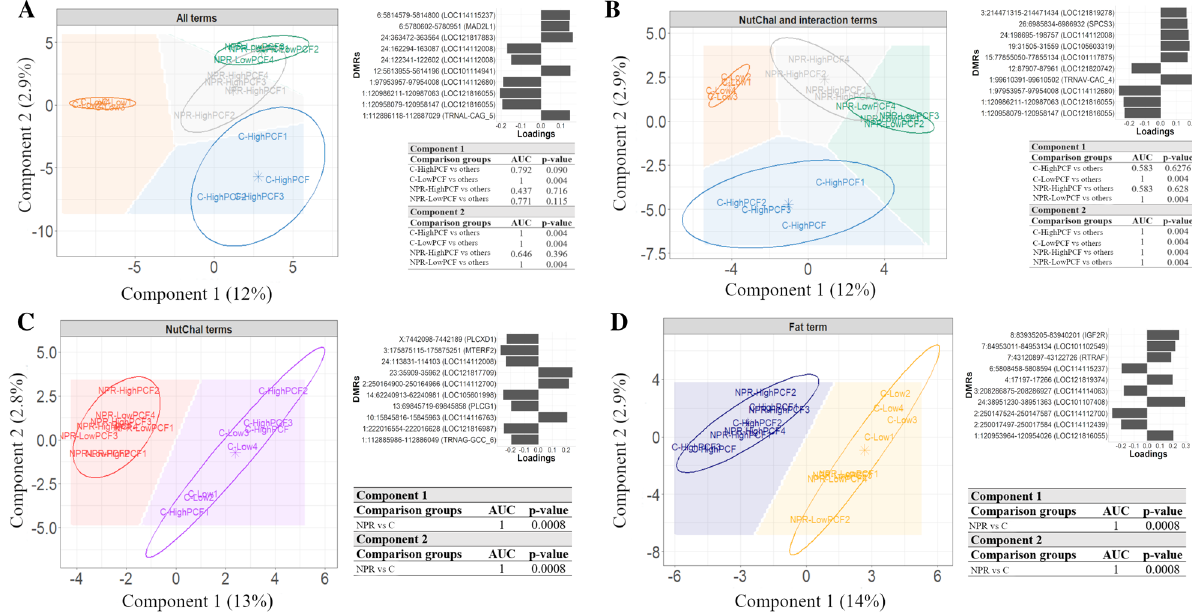
Figure 2. Results of partial least squares discriminant analysis (PLS-DA) and the top 10 loading vectors for the mean methylation levels within the identified differentially methylated regions (DMRs). ( A ) Discriminant analysis using the mean methylation level within the DMRs identified for the three terms of the multifactorial model (NutChal * FatGroup, NutChal, and FatGroup) to classify the four groups from the multifactorial model: lambs from control ewes with a low percentage of perirenal and cavitary fat (C-LowPCF in orange), lambs from control ewes with a high percentage of perirenal and cavitary fat (C-HighPCF in blue), lambs from nutritional challenge ewes with a low percentage of perirenal and cavitary fat (NPR-LowPCF in green), and lambs from nutritional challenge ewes with a high percentage of perirenal and cavitary fat (NPR-High in gray). ( B ) Discriminant analysis using the mean methylation level within the DMRs identified for only for the NutChal * FatGroup and NutChal terms to classify the four groups from the multifactorial model (C-LowPCF in orange, C-HighPCF in blue, NPR-LowPCF in green, and NPR-HighPCF in gray). ( C ) Discriminant analysis using the mean methylation level within the DMRs identified for the NutChal term terms to classify the NPR and C groups. ( D ) Discriminant analysis using the mean methylation level within the DMRs identified for the FatGroup term terms to classify the HighPCF and LowPCF perirenal and cavitary fat groups.